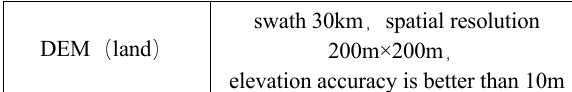
Table 2 . Data index of interferometric imaging radar altimeter To summarize, the optical images and SAR data from Tiangong- 2 have the following advantages for scene classification: